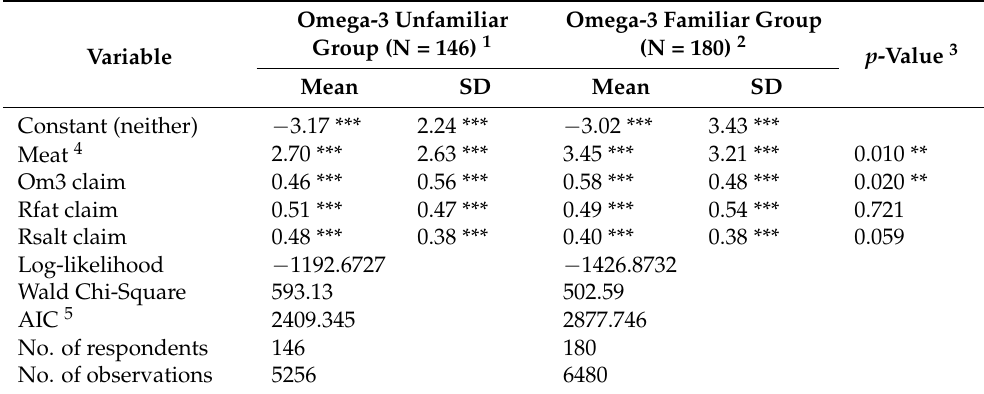
Table 5. WTP estimation by the omega-3-unfamiliar and -familiar